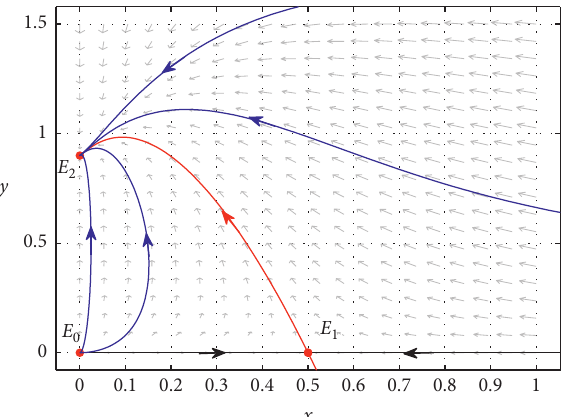
Figure 3: Phase portrait for system (12) with α � β � ρ � m � 1, c � 0 . 5, and δ � 0 . 1.